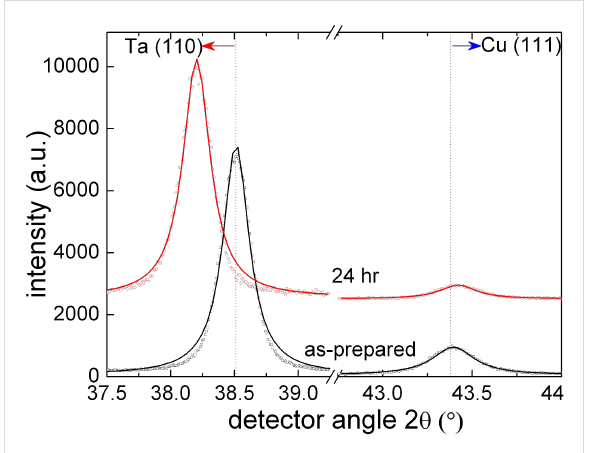
Figure 4: X-ray diffraction patterns (Cu K α radiation) of Fe nanoparti- cles embedded in a Cu film on a Ta substrate in the as-prepared state and after 24 h of loading with hydrogen. The solid lines represent fits to the measured data using Lorentz